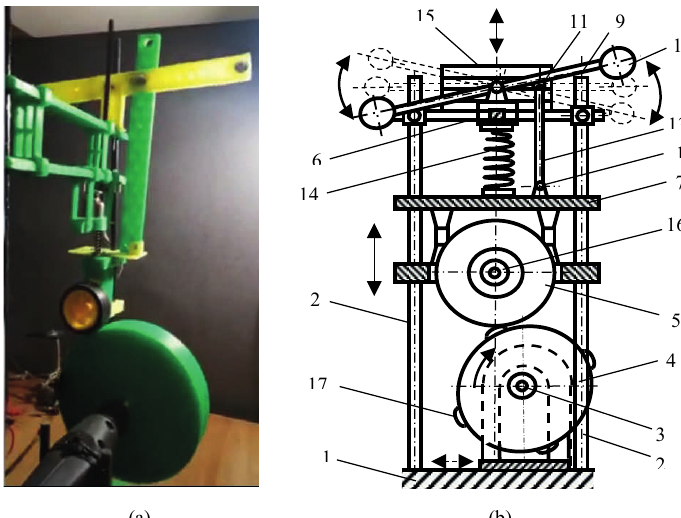
(b) Fig. 10. The vehicle’s recuperative suspension test-bench: a) working model; b) scheme. On the bench scheme, the circular arrow indicates the direction of rotation of drum; the dotted circular arrow indicates the direction of the drag torque of drum; the double arrows indicate the directions of vibrations; and the double dotted arrows indicate the directions of moving the